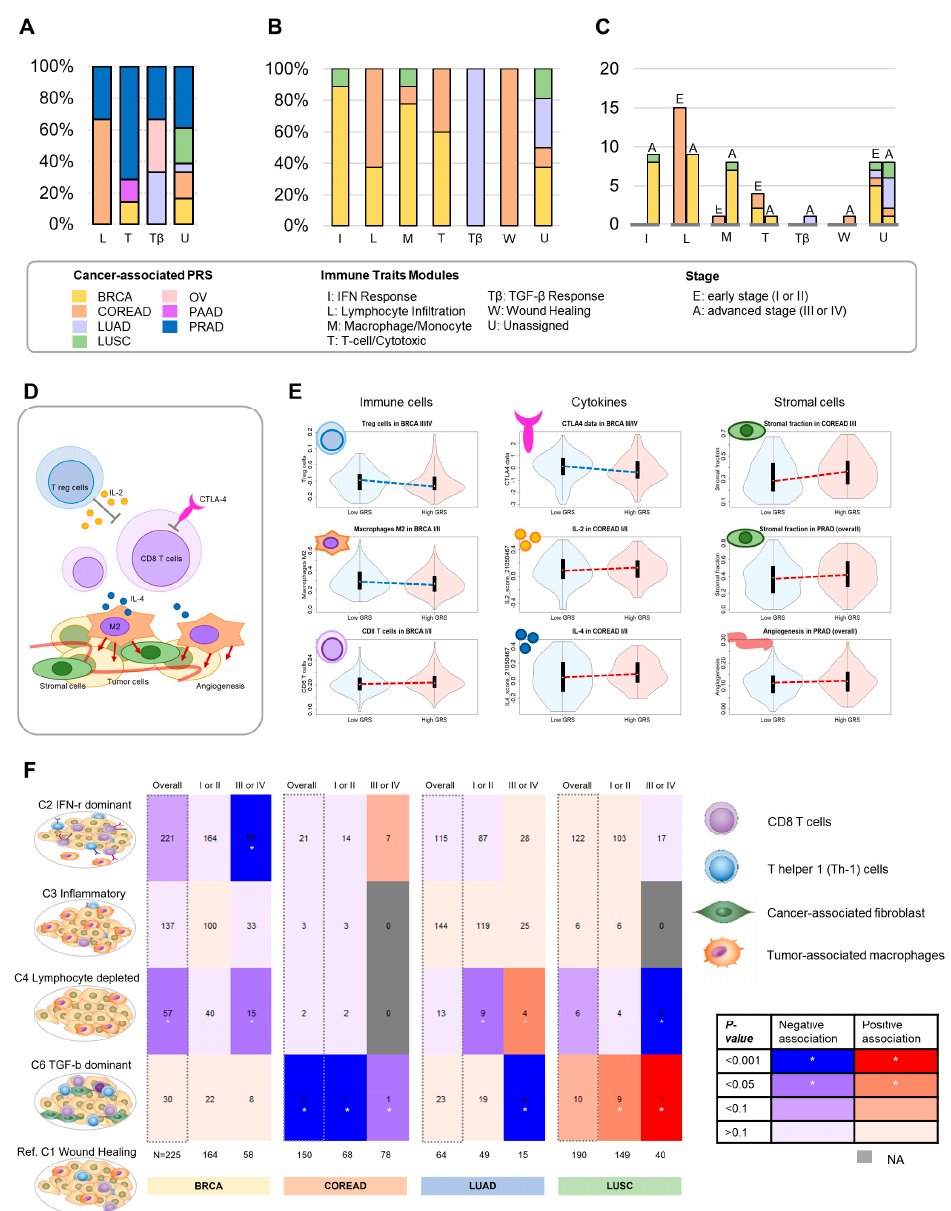
Figure 3. Summary of stratified analyses by stage and immune subtype. ( A ) Overall proportion of cancer types in each immune module (nominal p < 0.05). ( B ) Specific proportion by cancer stage in each immune module (nominal p < 0.05). ( C ) Absolute number of associations by cancer stage in each immune module (nominal p < 0.05). ( D ) Mechanisms of immune traits. Tregs attenuate the